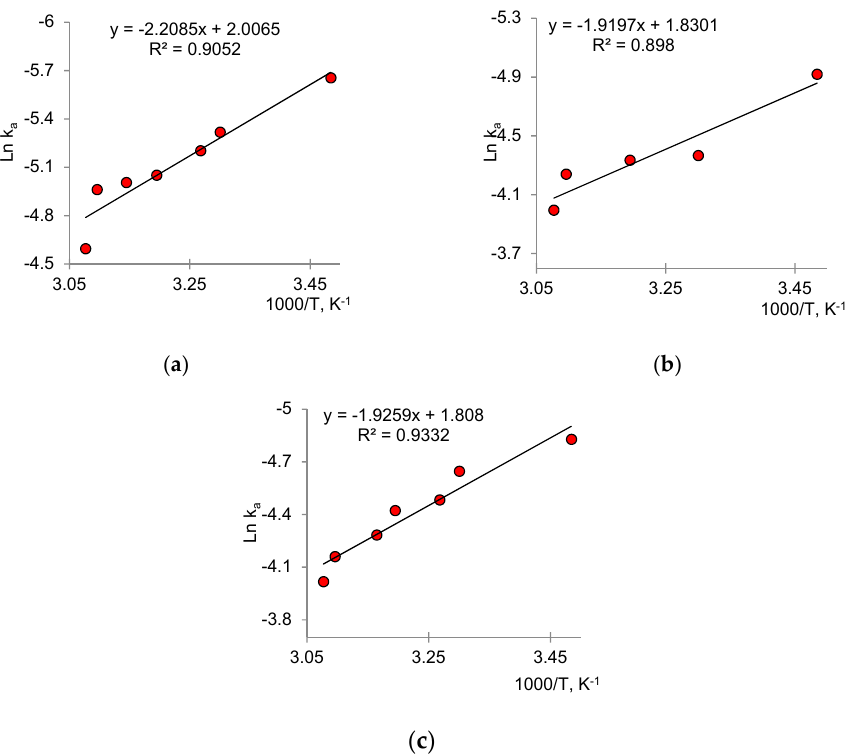
Figure 11. Arrhenius graphs for determining E A for ( a ) Cu 2 O@PET, ( b ) ZnO@PET and ( c ) Cu 2 O/ZnO@PET composite membranes. Table 3. Thermodynamic parameters of the degradation reaction of Czm. Composite E A ,